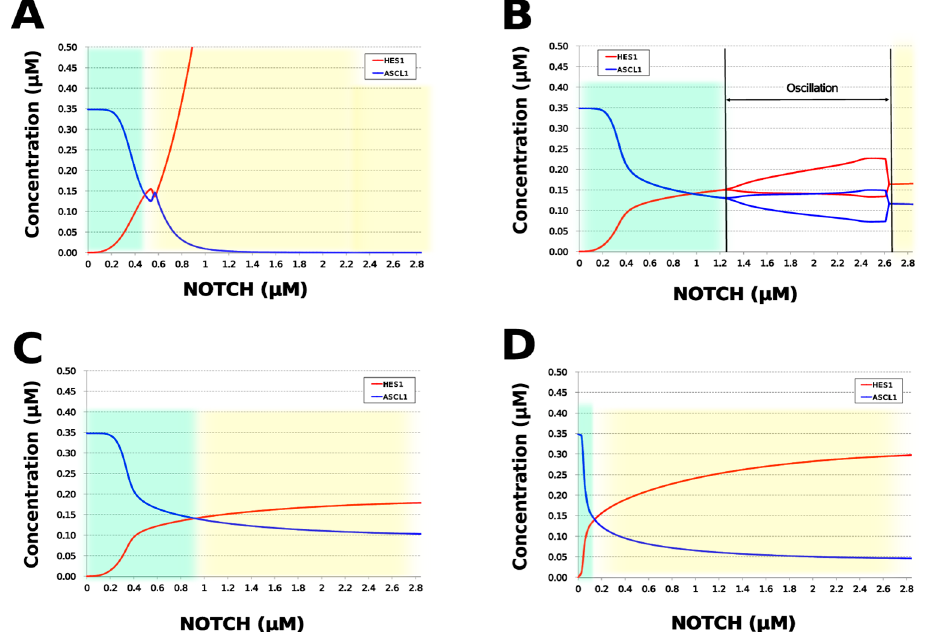
Figure 7. Bifurcation analysis of the HES1 and ASCL1 concentration dependence on the NOTCH concentration when each feedback loop is collapsed. ( A ) Collapsed HES1 self-feedback loop. ( B ) Collapsed negative-feedback loop between GSK3B and PTEN. ( C ) Collapsed positive-feedback loop between aPKC_PAR3_PAR6 and PI3K. ( D ) Collapsed negative-feedback loop between beta-catenin and HES1. Background colors show cell di ff erentiation state; green, neuron; yellow,